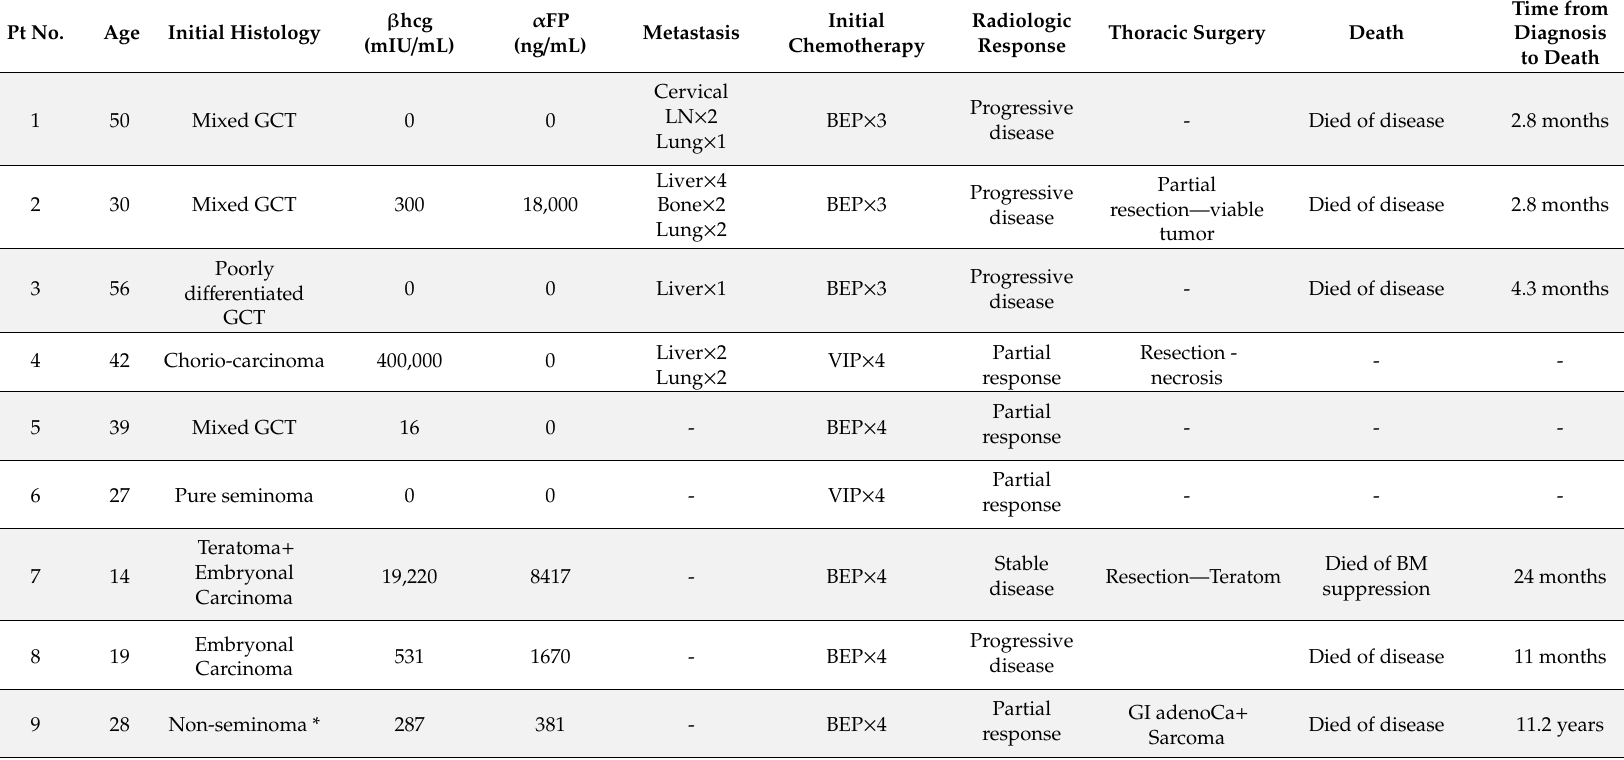
Table 1. Patient